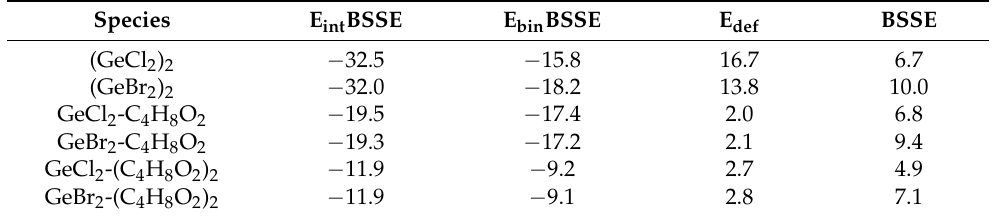
Table 3. MP2/aug-cc-pVTZ results of calculations (in kcal/mol); E int BSSE—interaction energy corrected for BSSE, E bin BSSE—binding energy corrected for BSSE, E def —deformation energy, BSSE— basis set superposition error correction.